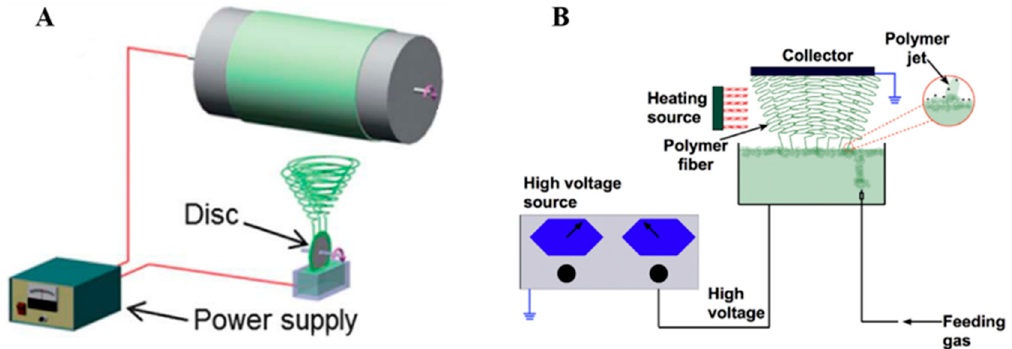
Figure 3. ( A ) Schematic diagram of needleless electrospinning [69]. ( B ) Bubble-electrospinning [71] .